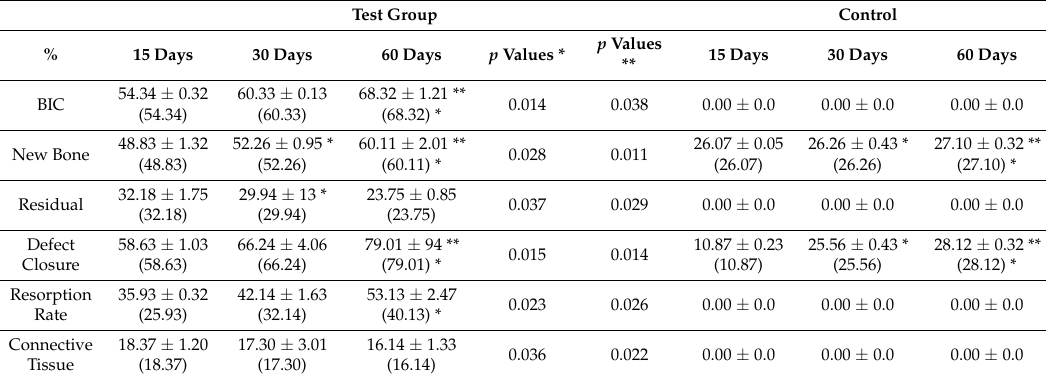
Table 1. The histomophometric analysis to evaluate the BIC for the Si ‐ TCP scaffold. Test Group Control %